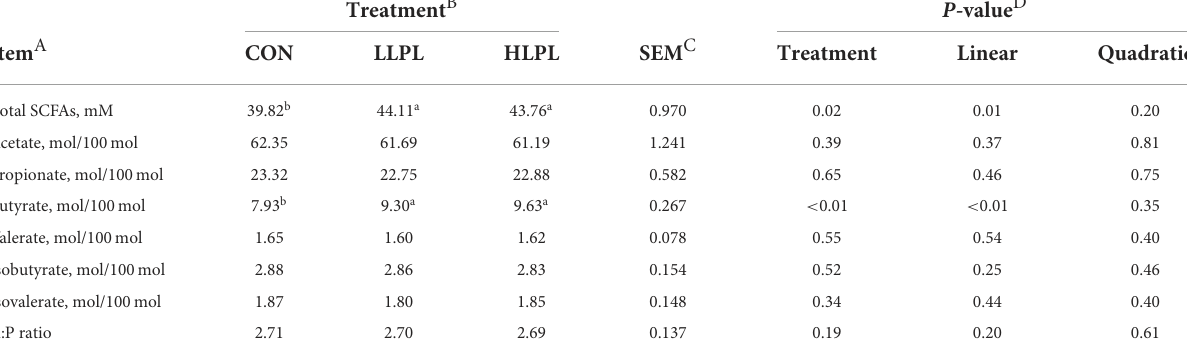
TABLE 6 Effect of dietary lysophospholipids supplementation on the fermentation of SCFAs in beef